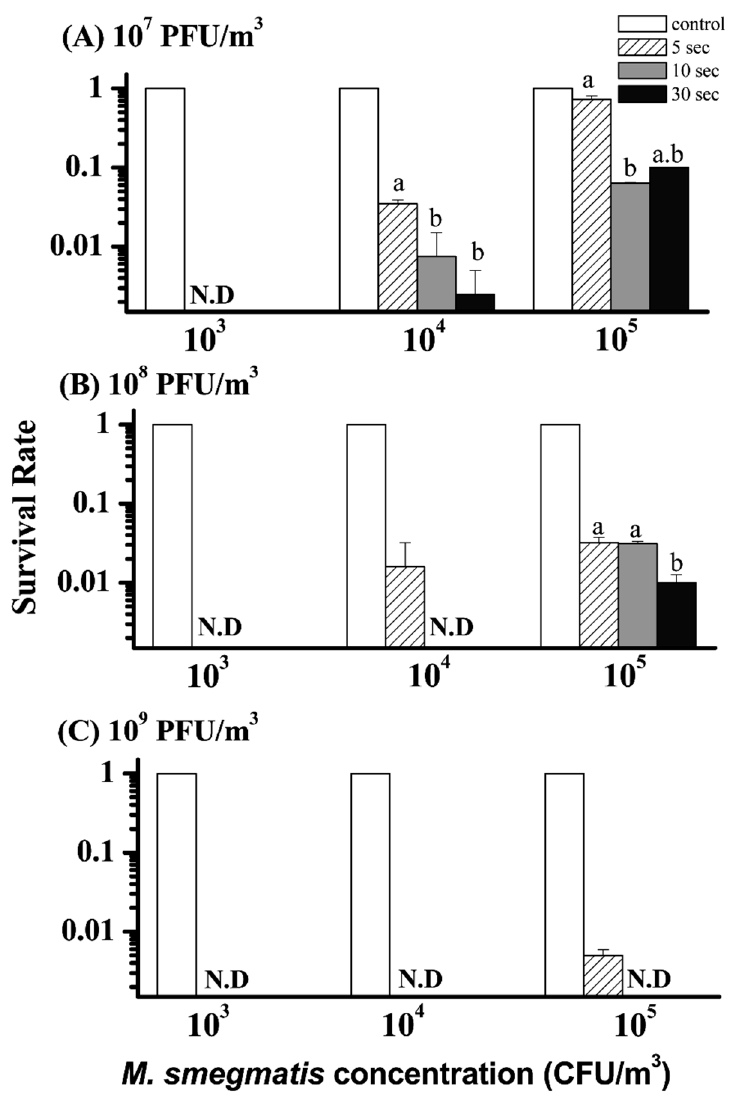
Figure 4. Bactericidal effect of different concentrations, ( A ) 10 7 , ( B ) 10 8 , and ( C ) 10 9 PFU/m 3 , of ϕ BTCU-1 aerosols on different concentrations of airborne M. smegmatis in the test chamber at three times of 5, 10, and 30 s sampling by an Andersen 1-STG impactor (phase one study). The survival rate was calculated as the log 10 of N t /N 0 , where N 0 is the number of bacterial colonies recovered from challenging with water fog and N t is the number of colonies recovered from challenging with ϕ BTCU-1 aerosol. The histogram bars with the same letter represent that they have similar survival rates that are not significantly different ( p > 0.05, Dunn's multiple comparison test). Experiments were performed in triplicate and the data shown represent the mean ± standard error of the mean. N.D. means not detected.